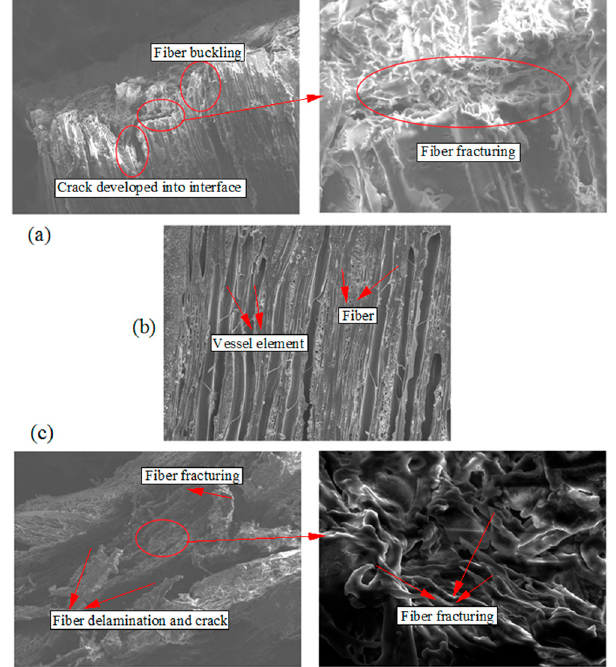
Figure 13. Microstructures of beech specimens ( a ) in DTLD, ( b ) before being loaded, and ( c ) in DTRD.